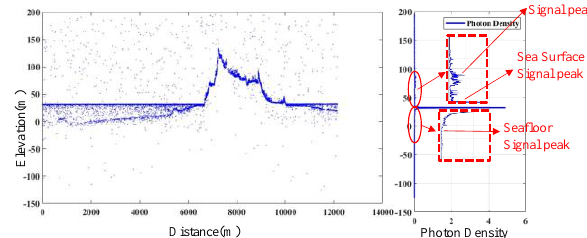
Figure 2. A typical histogram of photons for an island/reef zone